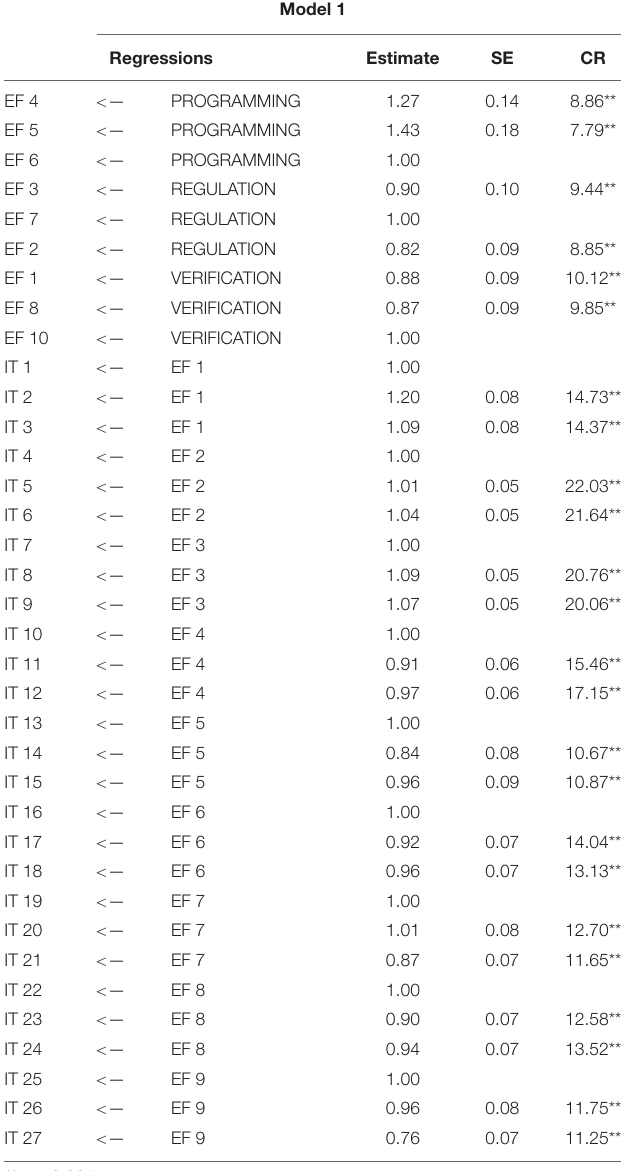
TABLE 6 | First model’s regression